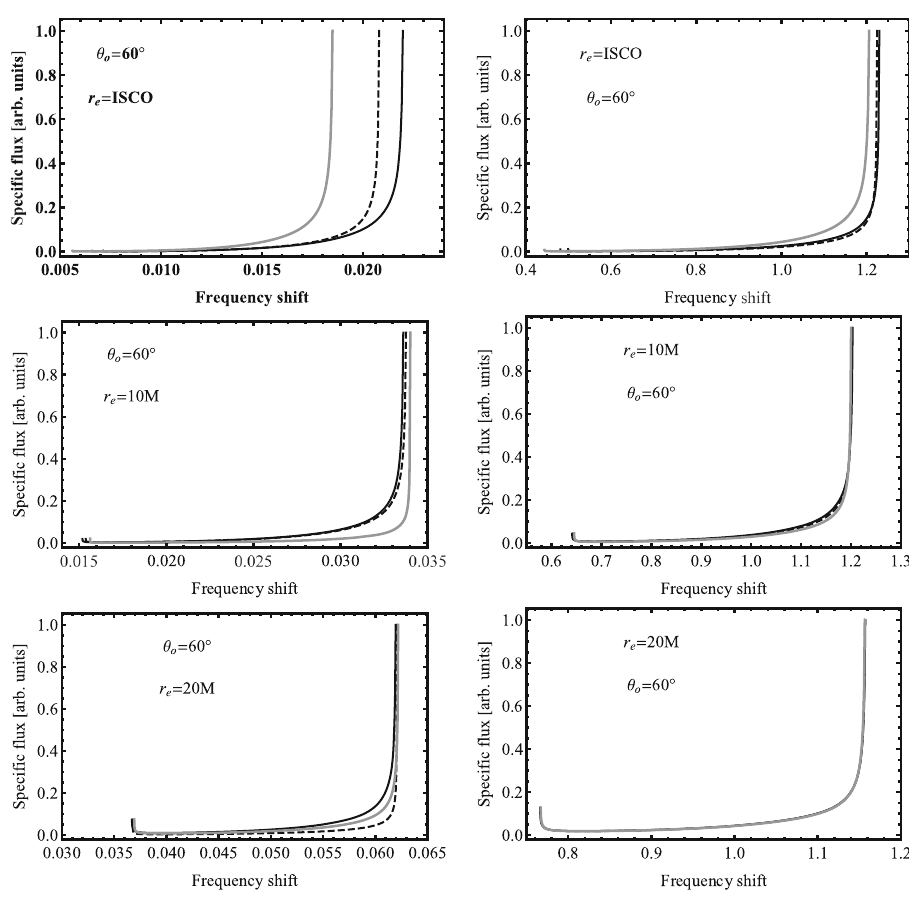
Fig. 2 Ring profiled spectral line generated for three representative values of “magnetic charge” parameter q m = 0 . 05 M (black), 0 . 5 M (black, dashed), and 0 . 768 M (thick, gray) and three Keplerian ring radii r e = r ISCO ( q m ) (top), 10 M , and 20 M (bottom). The observer inclination is θ o = 60